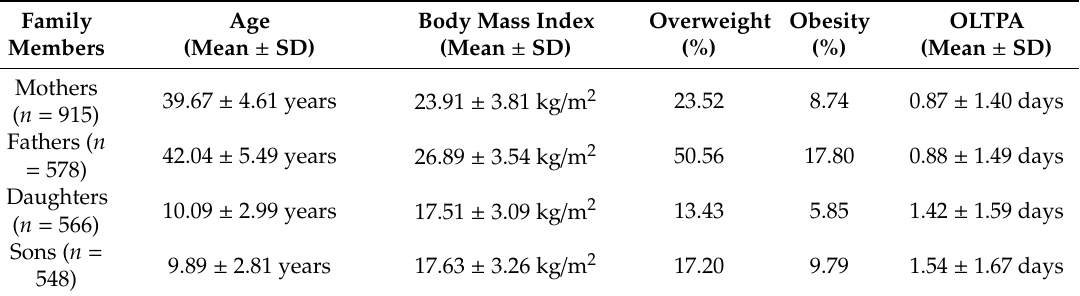
Table 1. Final set of family dyads (mother-daughter n = 456, mother-son n = 459, father-daughter n = 288, father-son n = 290) with valid physical activity and anthropometric